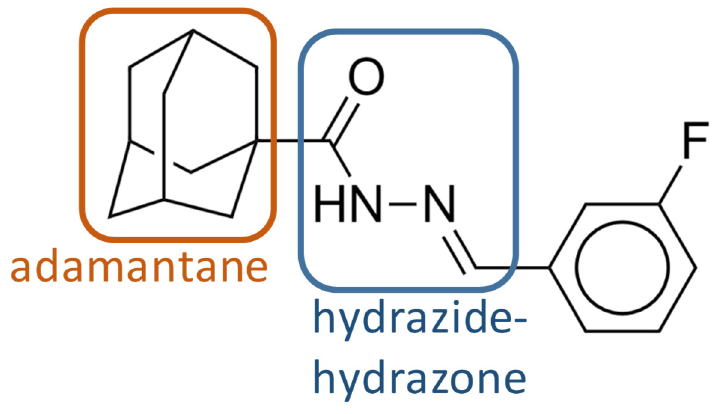
Figure 1. Compound 1 identified during the screening. The adamantane and hydrazide–hydrazone moieties are indicated.